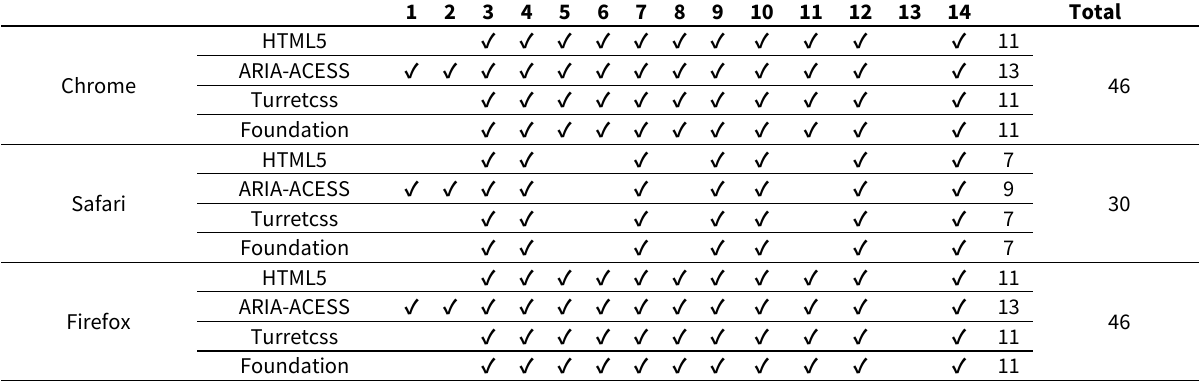
Table 2. Form test results. The check means that it was possible to execute the task for the indicated technology and browser. Each check computed one unit in the total